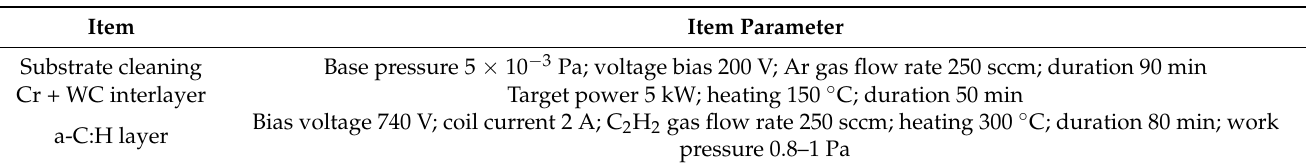
Table 2. Summary of a-C:H film deposition parameters. Item Item